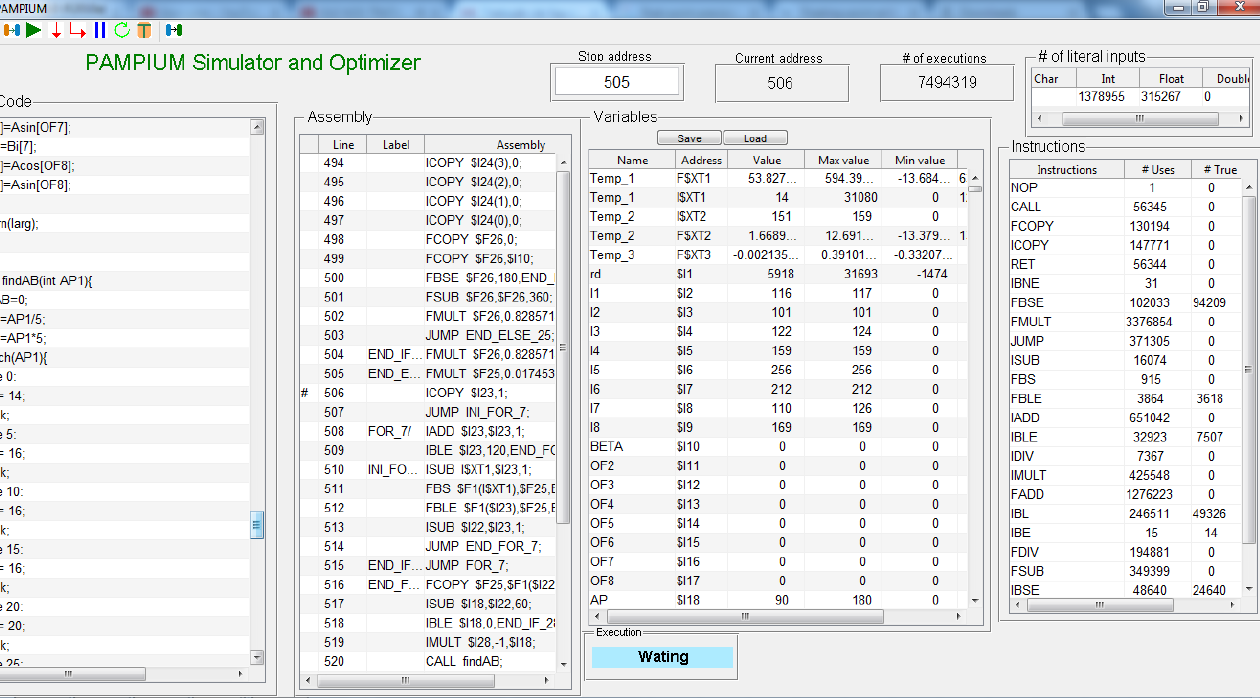
Figure 17. ASIPAMPIUM graphical user